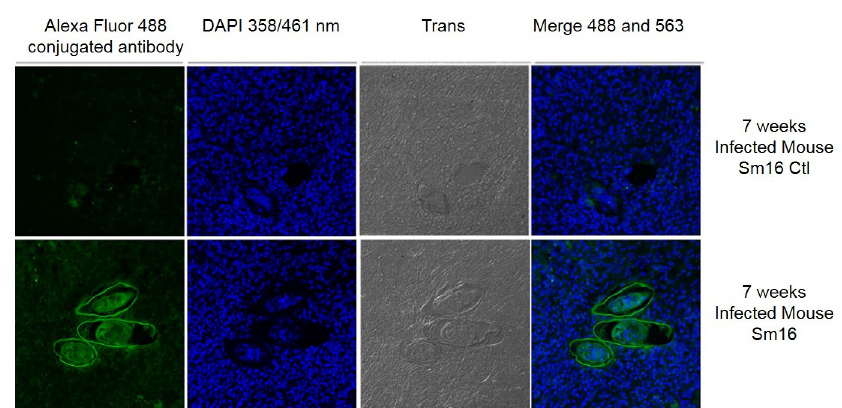
Fig 4. Immunolocalisation of Sm16 in S . mansoni eggs. Paraffin was embedded liver sections of S . mansoni -infected (7 weeks post-infection) containing S . mansoni eggs were probed with anti-Sm16 antibody represented by green fluorescence. For the negative controls (Ctl) the anti-Sm16 antibodies were first adsorbed with an excess of recombinant Sm16 prior to being used in the protocol. Nuclear staining was carried out using DAPI represented by blue fluorescence. The Trans panels shows the sections under light microscopy.